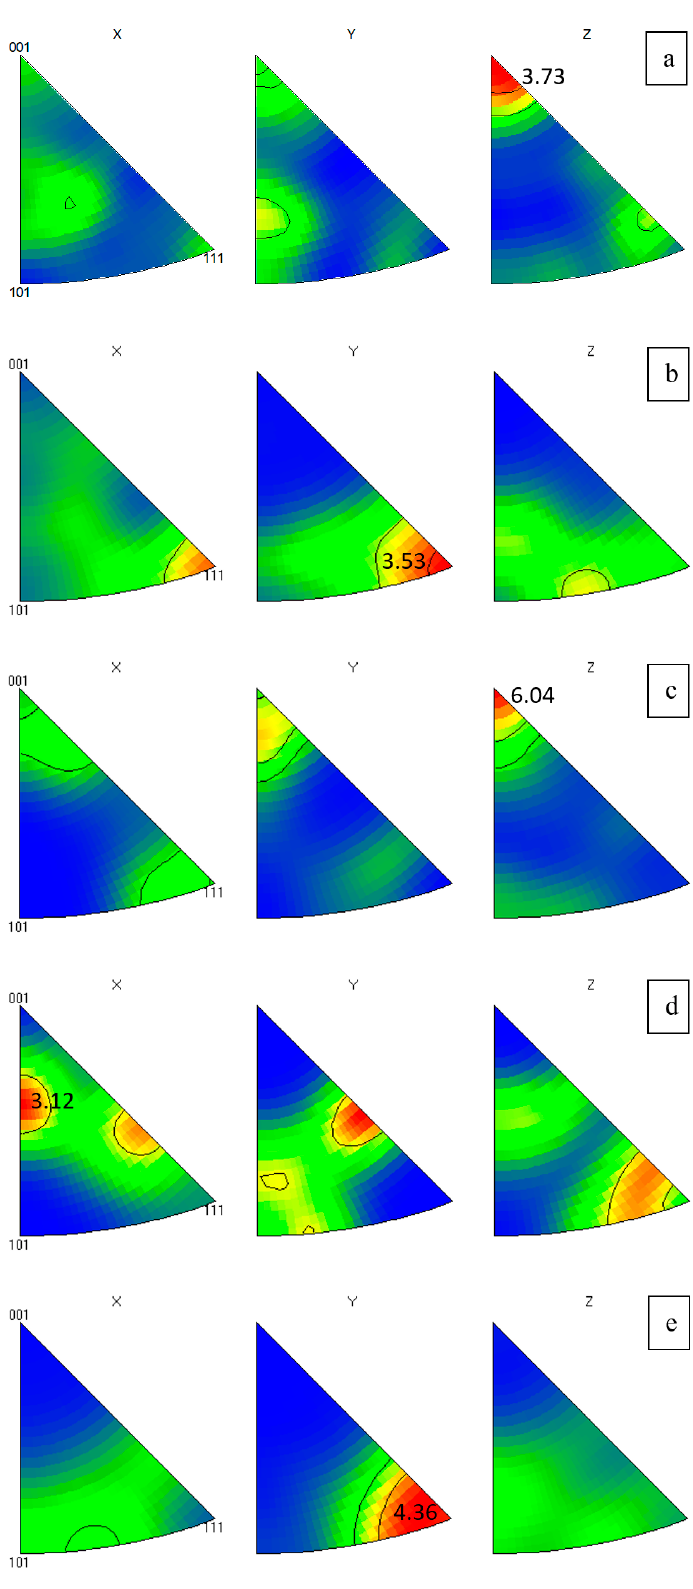
Figure 7. IPF contour maps of Figure 6 representing ( a ) BM, ( b ) Area I, ( c ) Area II, ( d ) Area III, and ( e ) Area IV.